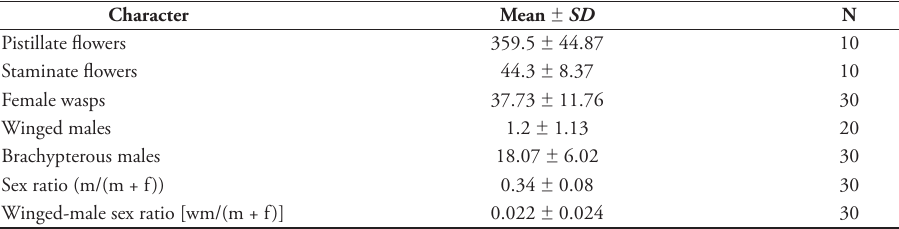
Table 1. Number of flowers and wasps in figs sampled in Ribeirão Preto. N = number of figs, m = males, f = females, wm = winged